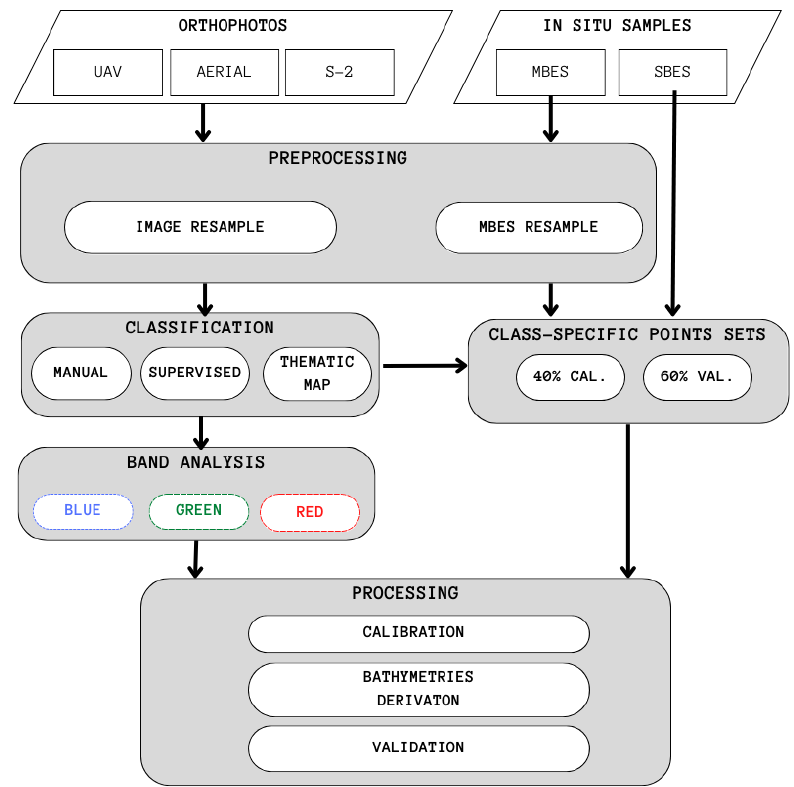
Figure 5. Remote-Derived Bathymetry workflow: from input data to pre-processing, classification, band analysis and processing